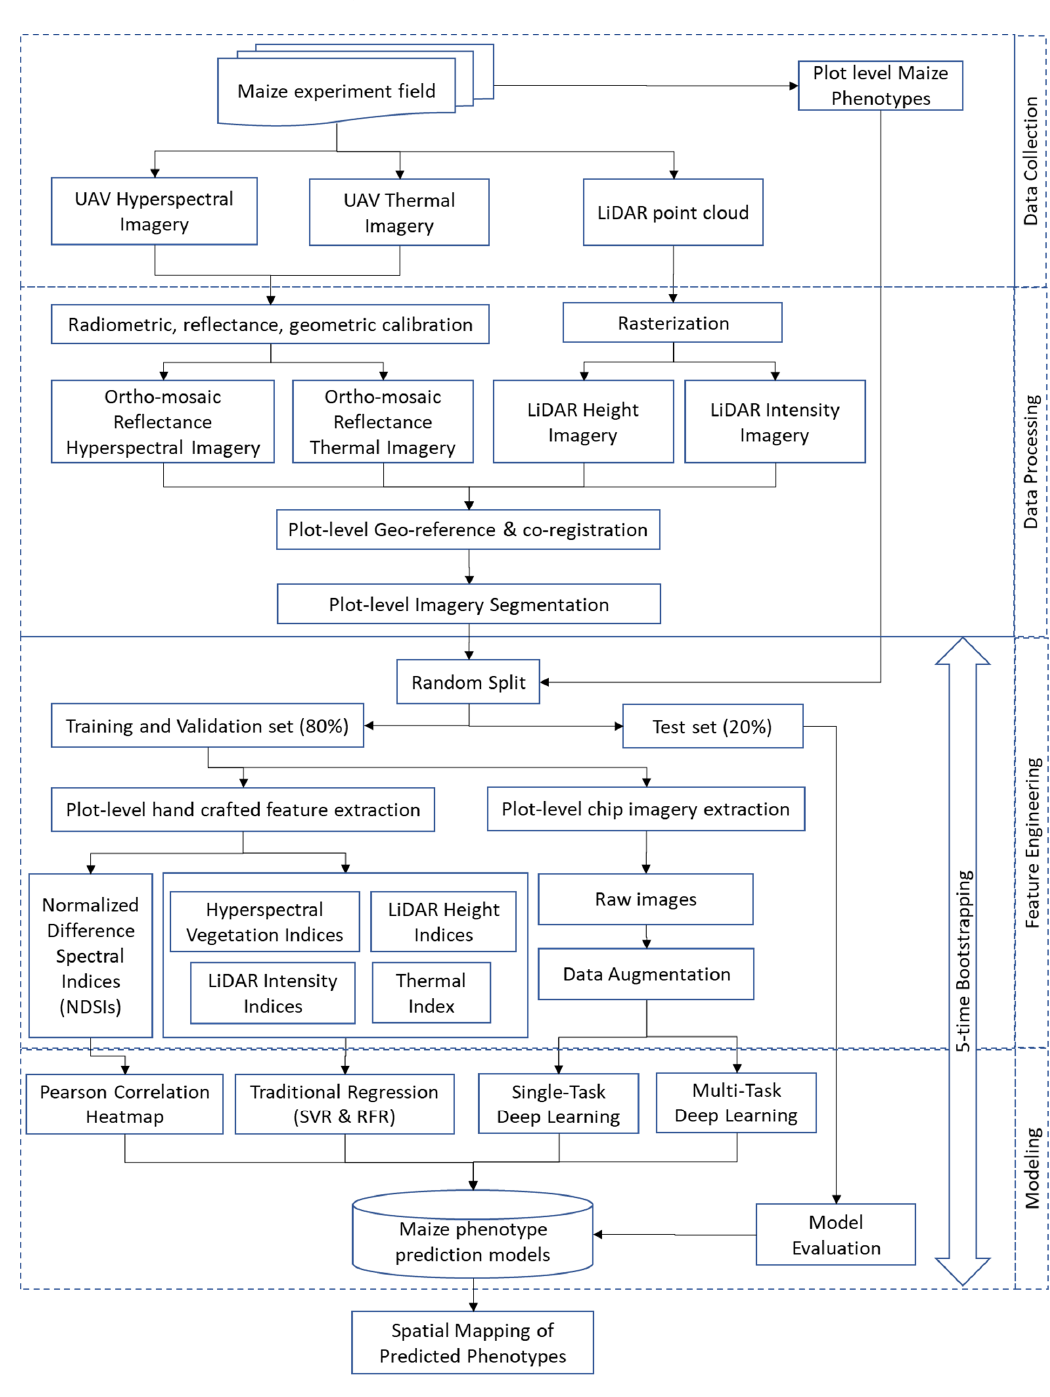
Figure 3. Overall workflow implemented in the study. There were four main stages: UAV data collection, remotely sensed data processing, feature engineering, and modelling. Because of a small sample size and the existence of extreme values in the data, the feature engineering and modelling phases were iterated 5 times by randomly shuffling the datasets (bootstrapping). The best predicted phenotypes were eventually plotted on spatial maps as final deliverables.